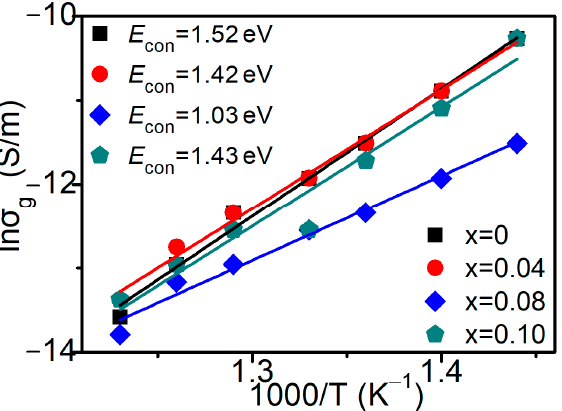
Figure 6. Arrhenius plots and fitting results as well as corresponding activation energy of grain conductivity for KNNS x -BNN ceramics. conductivity for KNNS x -BNN ceramics.